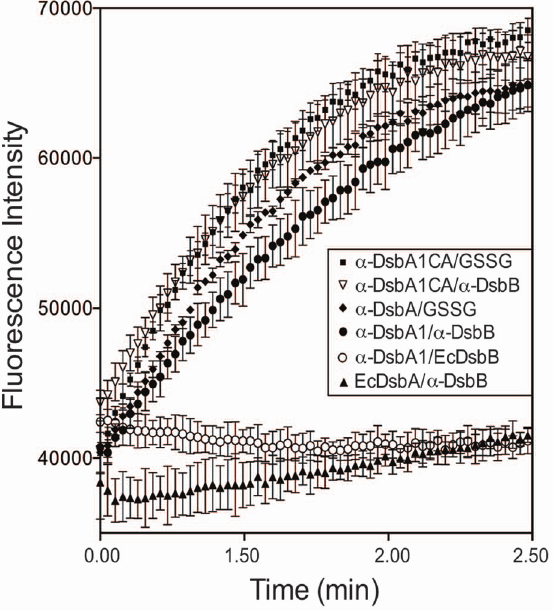
Figure 7. Peptide dithiol oxidation catalyzed by a -DsbA1. Fluorescence curves showing oxidation of a thiol-containing peptide catalyzed by: a -DsbB membranes with a -DsbA1 and a -DsbA1CA; EcDsbB membranes with a -DsbA1; a -DsbB membranes with EcDsbA; or glutathione with a -DsbA1 and a -DsbA1CA. Data represent the standard mean and error of three